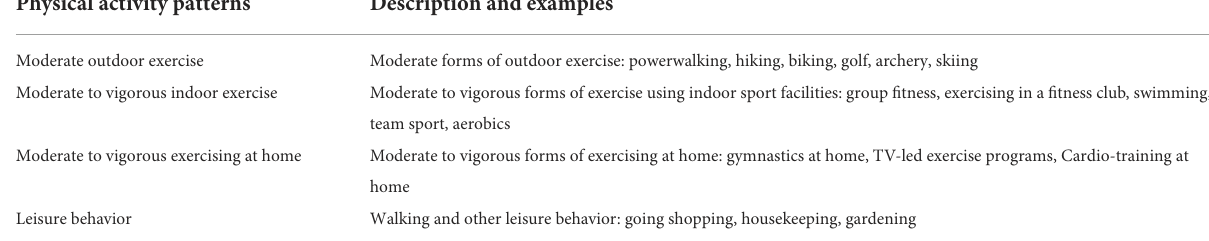
TABLE 4 Description and examples of physical activity patterns derived from content analysis. Physical activity patterns Description and